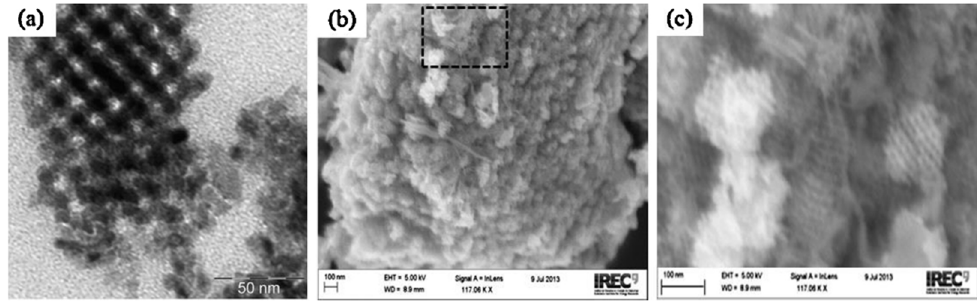
Figure 23. ( a ) TEM image of mesoporous WO 3 , ( b ) SEM image of mesoporous WO 3 , and ( c ) magnification of the area marked by the dotted line square in ( b ) [37]. Reproduced with permission from Villa et al. Copyright © 2022 Elsevier.